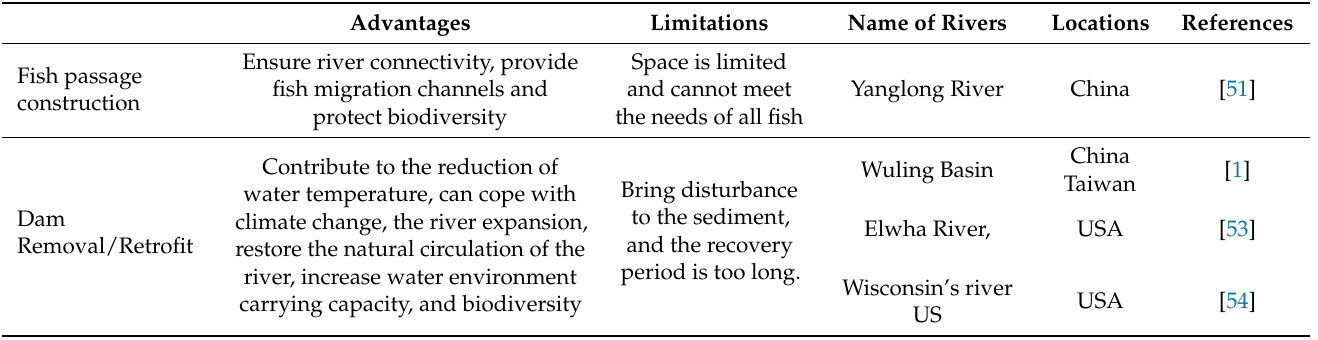
Table 2. Advantages and Limitations of different physical infrastructure